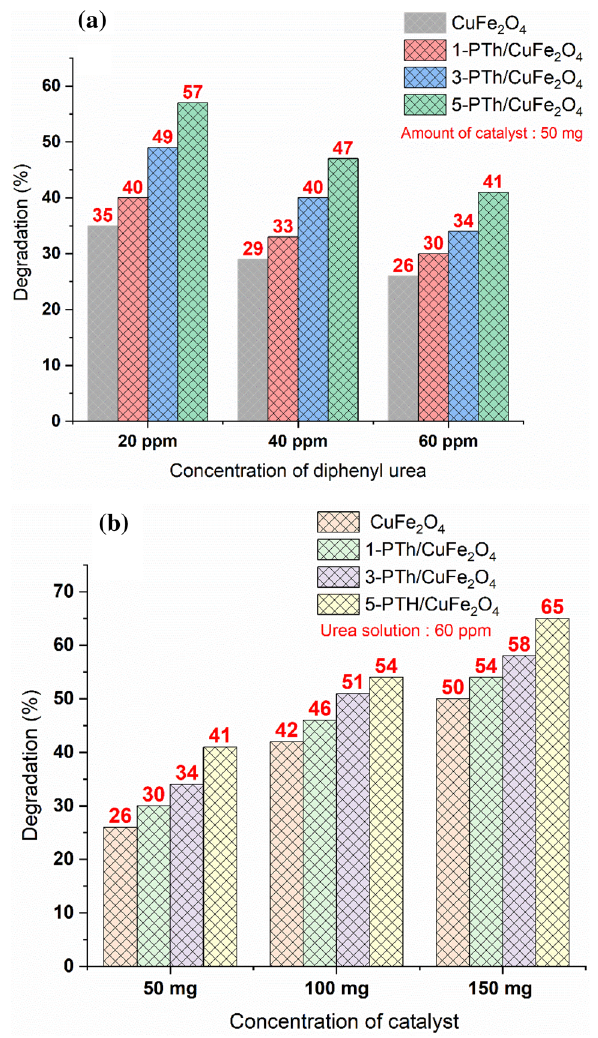
Figure 3. ( a ) Effect of diphenyl urea concentration ( b ) Effect of photocatalyst concentration on the degradation behavior of the